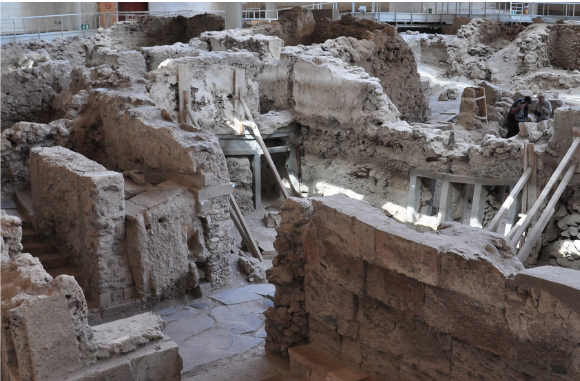
Figure 1: Excavated walls of the building Xeste 3 at Akrotiri just propped up with wooden beams, vulnerable to destruction in the case of